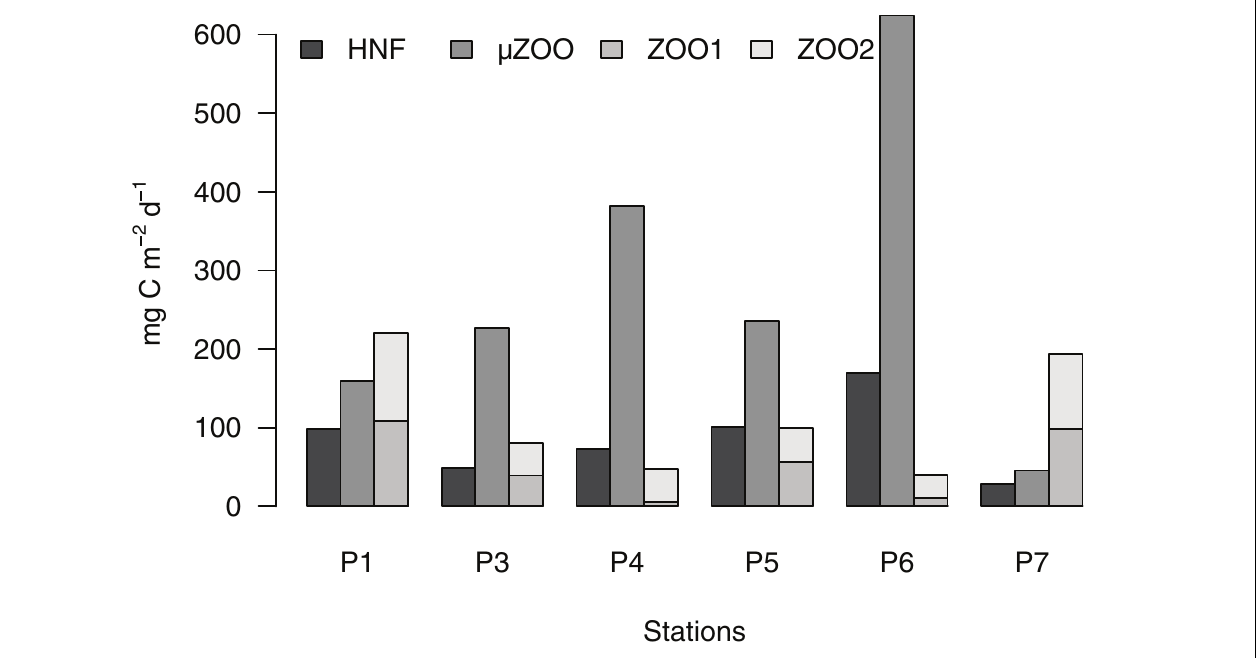
FIGURE 9 | Partitioning of sum of grazing flows into the main heterotrophic grazer compartments. The mesozooplankton compartments are stacked to give the total carbon flow into mesozooplankton.